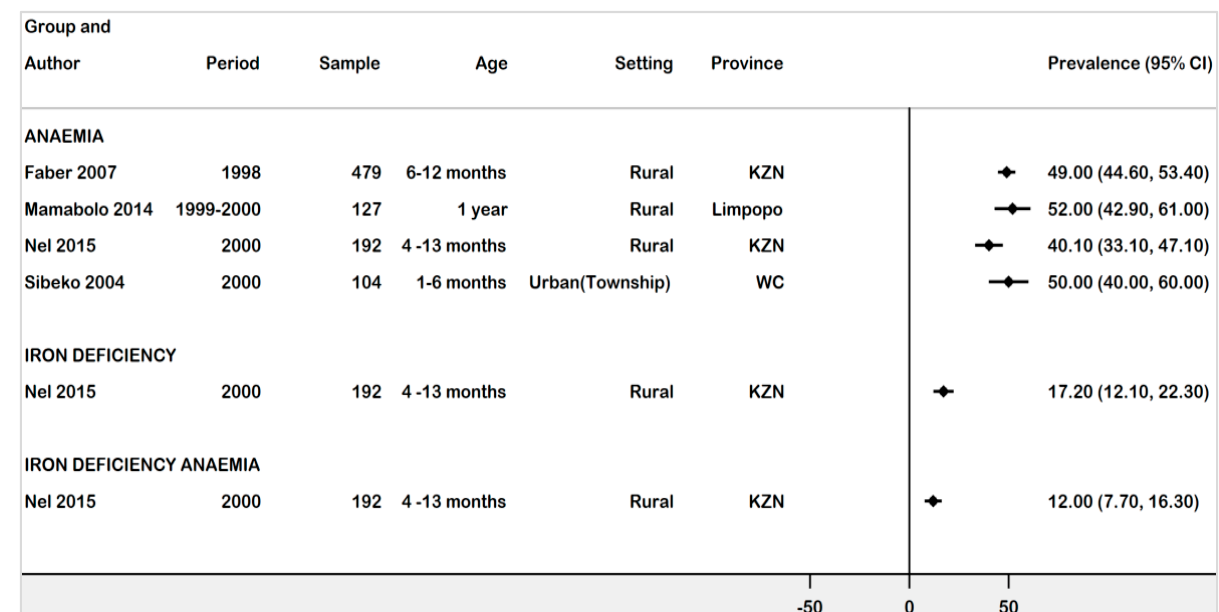
Figure 4. Forest plot of prevalence of anaemia, ID, and IDA in infants aged 1 − 13 months in South Africa, 1997-2021.